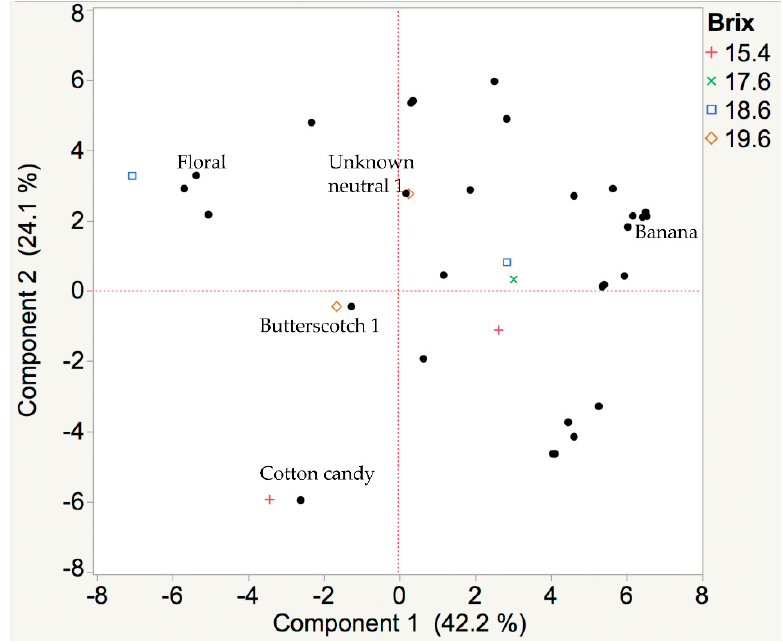
Figure 4. A PCA biplot of aromas from Brianna wines made from berries harvested at four different ripening stages. Wines were made from Brianna cold-hardy grapes harvested at 15.4, 17.6, 18.6, and 19.6 °Brix. The juice was adjusted to 20 °Brix for all time points prior to fermentation. Wine headspace samples were collected by SPME and analyzed with GC-MS-O. Aroma descriptors were recorded by a trained human panelist. A shift of the aroma profile from “cotton candy” to “banana” to “floral” to “butterscotch” was observed. Over 68% of the variation in harvest time is correlated with key odor-active compounds.